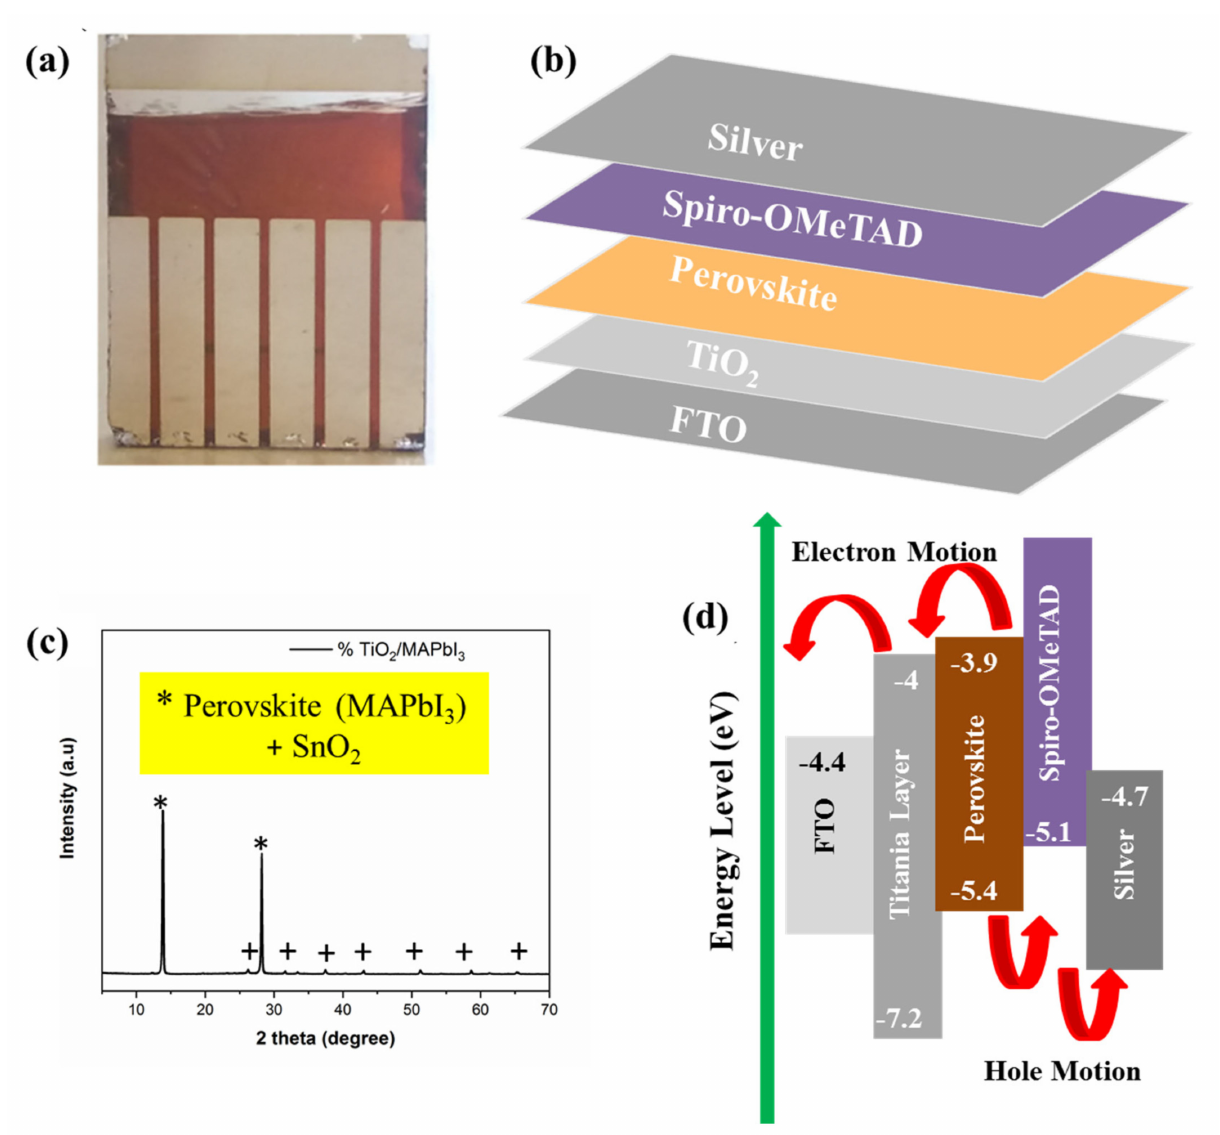
Figure 2. ( a ) Perovskite solar cell complete lab fabricated device. ( b ) The device schematic architecture. ( c ) The XRD for the perovskite layer. ( d ) Device energy level